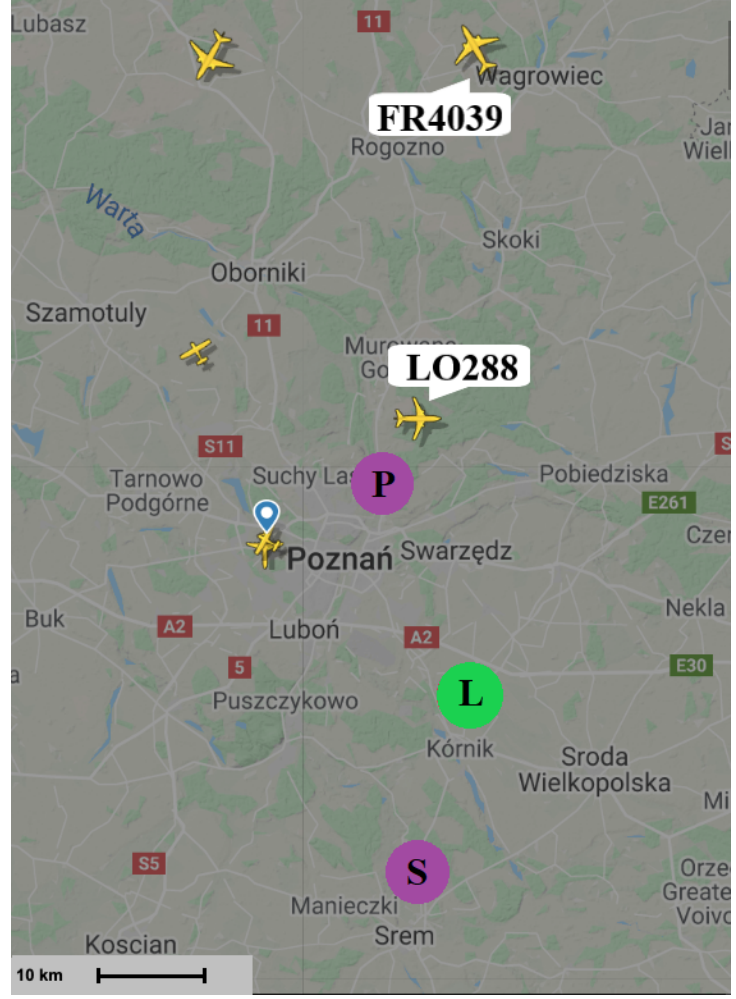
Figure 15. Situation in the air during measurement—December 2019 [39]. Table 4. Bistatic target parameters for the transmitter in Srem—December 2019.